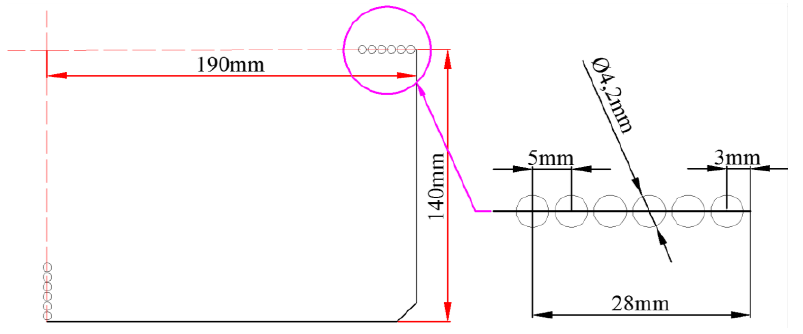
Figure 5. Distributions of drilling samples in the initial solidified shell.